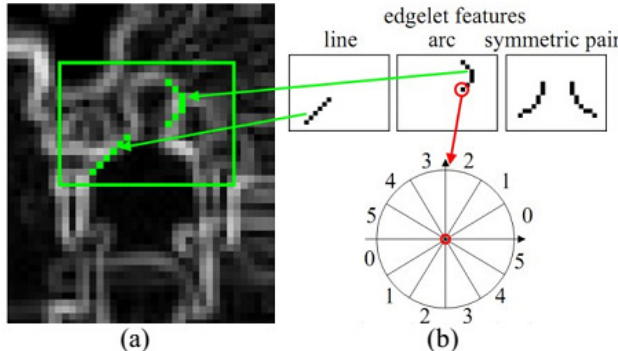
Figure 7. Edgelet features [230]. ( a ) The Sobel convolution result; ( b ) Examples of edgelet features and orientation quantization.